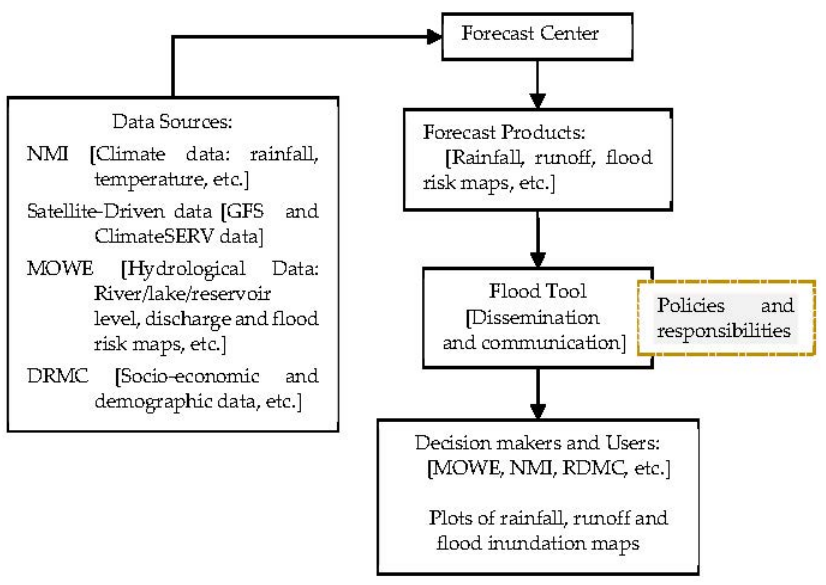
Figure 12. Flood forecast and warning system and exchange.